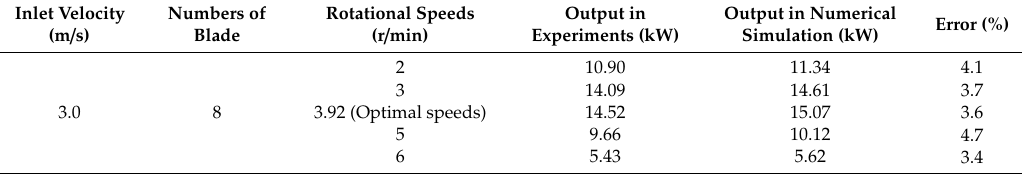
Figure 5. Model of the water wheel and field experiment. Table 1. Output of experiment and numerical simulation at an immersed depth of 0.8 m.